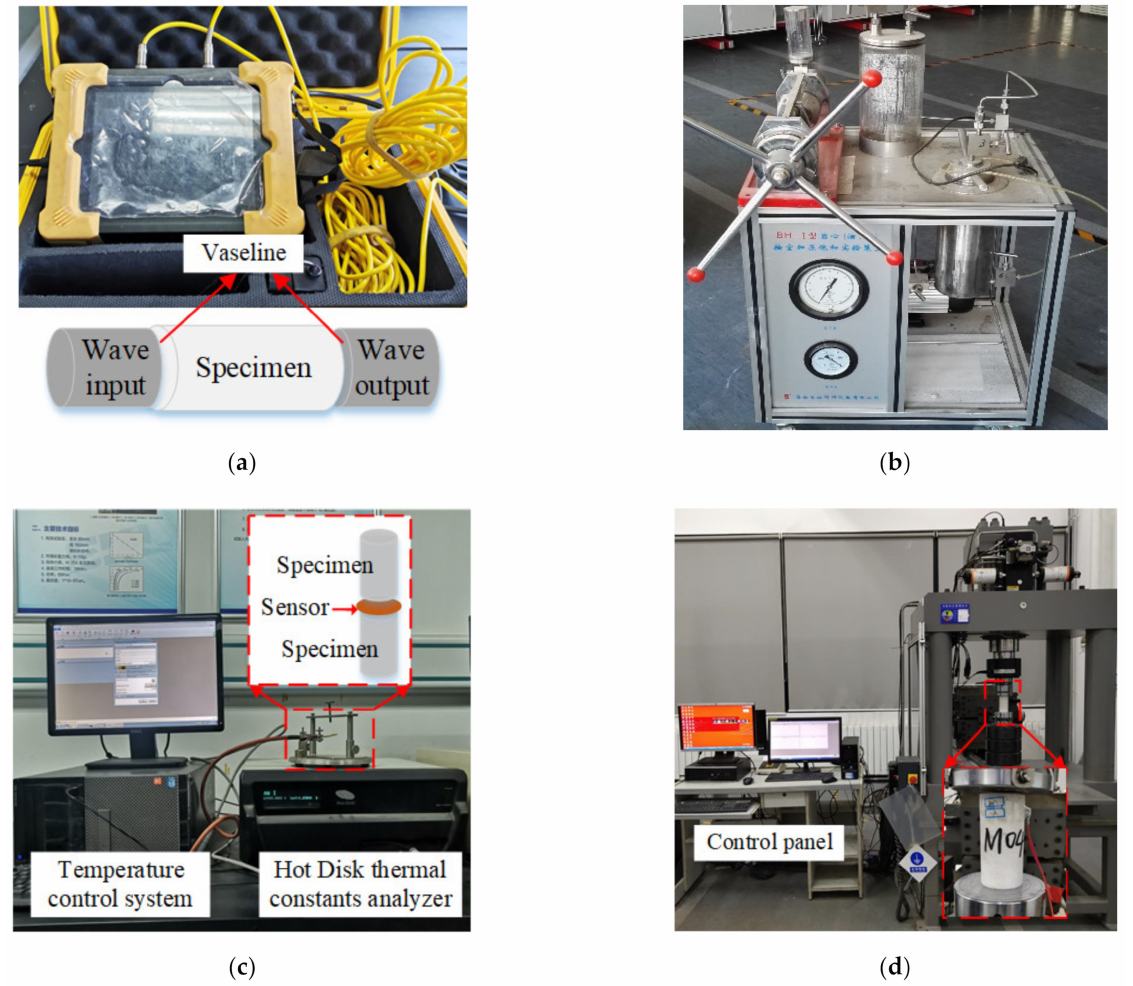
Figure 3. The images of ( a ) HC-U81 ultrasonic wave tester, ( b ) BH-1 rock porosity test system, ( c ) Hot Disk thermal constants analyzer and ( d ) MTS 816 servo-controlled rock mechanics test